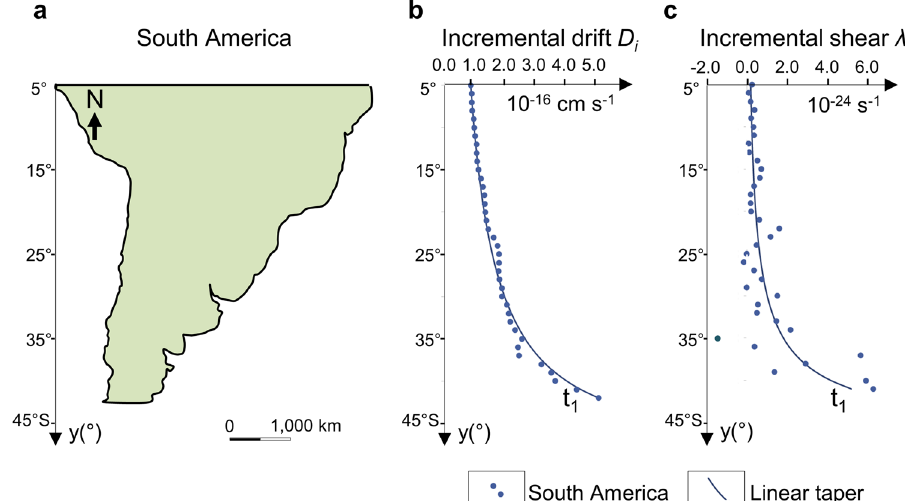
Fig. 9 Analytical modeling and numerical simulation results showing southward increasing drift and right-lateral shear of the tapering continent of South America during the initial phase (t 1 ). See Methods and Supplementary Table 1 for inputs and outputs, and Supplementary Data 1 to replicate the simulation. Incremental drift and shear are both plotted against latitude along the y-axis. The dots are calculated results from the non-linear taper of the South American continent. The curves are calculated results from a linear taper with the average tapering angle of the South American continent. As the South American continental width decreases from north to south, drift and shear increase, causing clockwise rigid rotation and intraplate right-lateral shear deformation. a Tapering continent of South America with its width decreasing non-linearly from north to south. b Incremental drift D i ( y , t ) in the initial phase (t 1 ). c Incremental shear λ i ( y , t ) in the initial phase (t 1 ). Note an overwhelming majority of shear strain is positive (right-lateral) because overall continental width decreases from north to